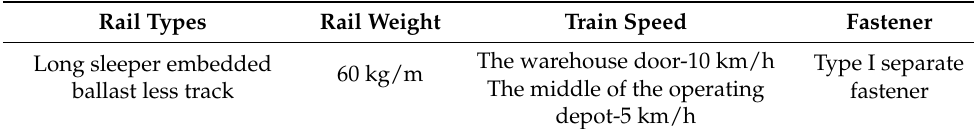
Figure 1. The plan view of the presented depot. Table 3. Train and track parameters in the operating metro depot.